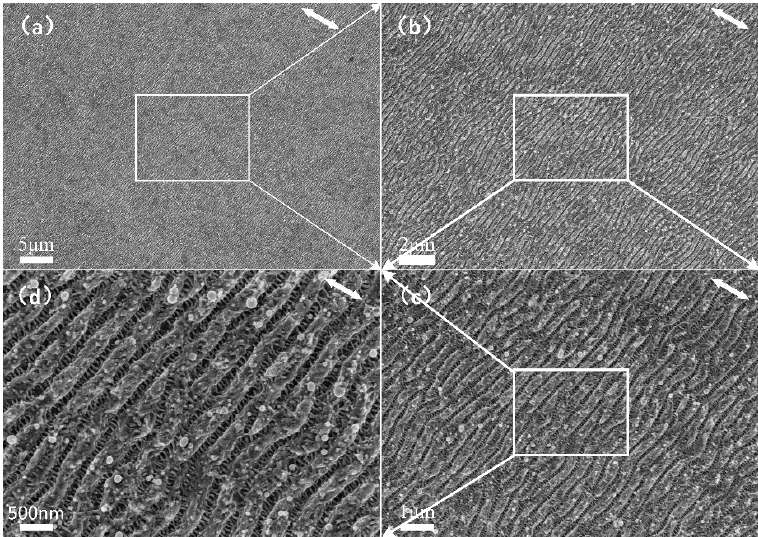
Figure 7. SEM micrographs of the prepared large-area hierarchical periodic NSRs and DSRs on the stainless-steel sample surface. ( a – d ) is the magnified picture of the selected area which indicated by a rectangular of white